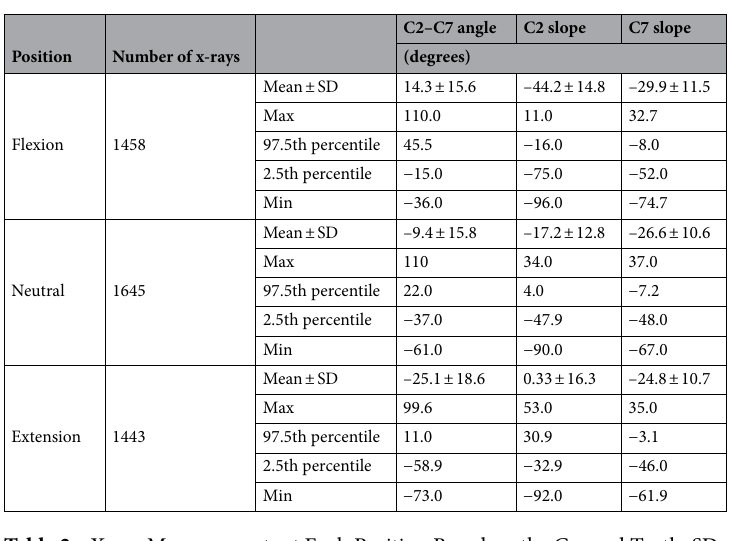
Table 2. X-ray Measurements at Each Position Based on the Ground Truth. SD, standard deviation.